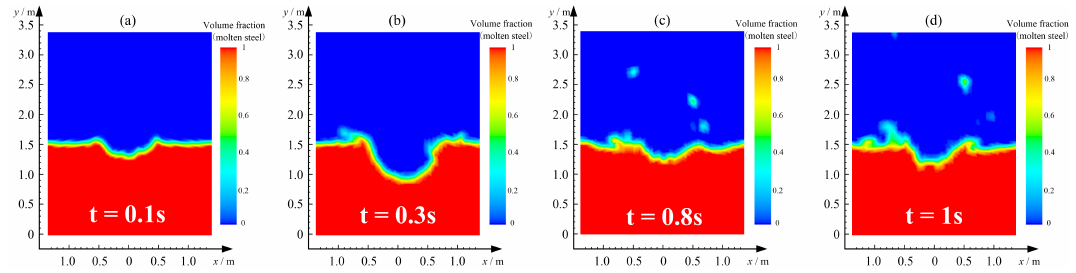
Figure 12. Spray of molten bath in the preliminary stage of top-blowing with a 0 ◦ nozzle twist angle